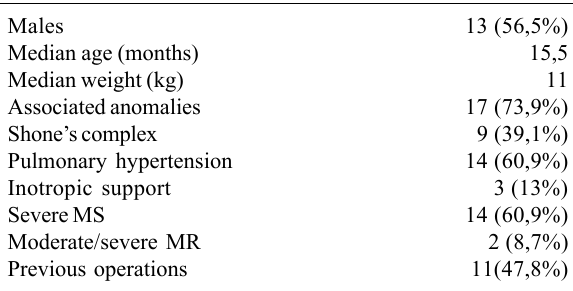
operations (Table 3). All patients with coarctation of the aorta were repaired previously to the mitral valve procedure. Table 2. Associated cardiac anomalies Associated anomalies Coarctation of aorta Shone’s complex